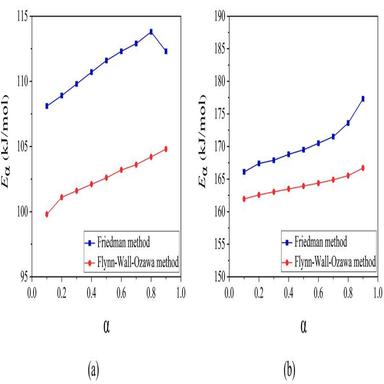
Activation energy values for the degrading of energetic ionic salts 2 (a) and 3 (b) were determined through the analysis of FWO and Friedman methods.